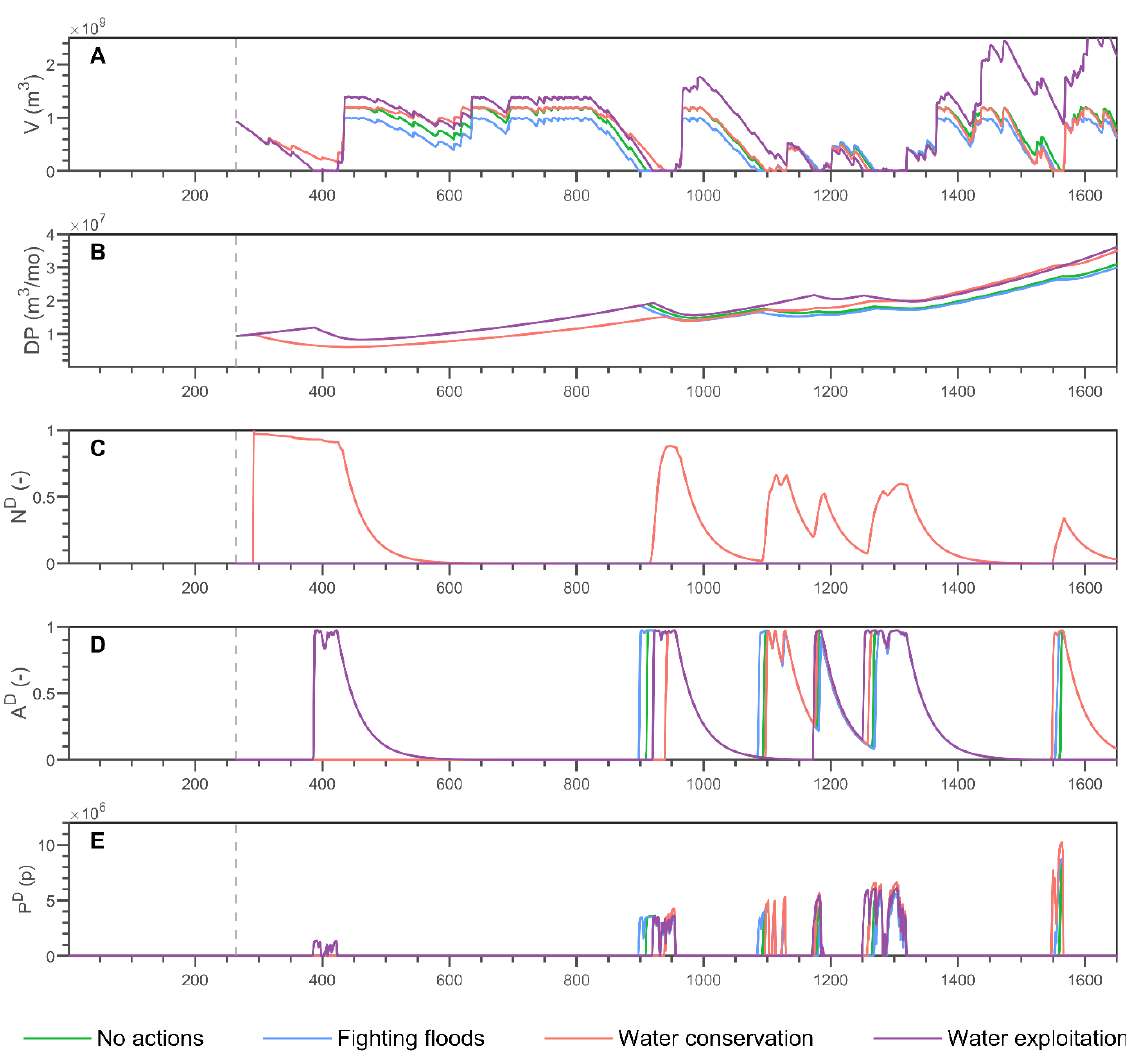
Figure A17. Water shortage-based variables of the synthetic experiments additional scenario #5 considering dam construction and human-flood interactions with the four water management strategies introduced in this study. (A) reservoir volume (V), (B) total water demand (DP), (C) willingness to the new per-capita demand (ND), (D) drought awareness (AD), and (E) population affected by droughts (PD). The grey dashed line indicates the construction of the Wivenhoe